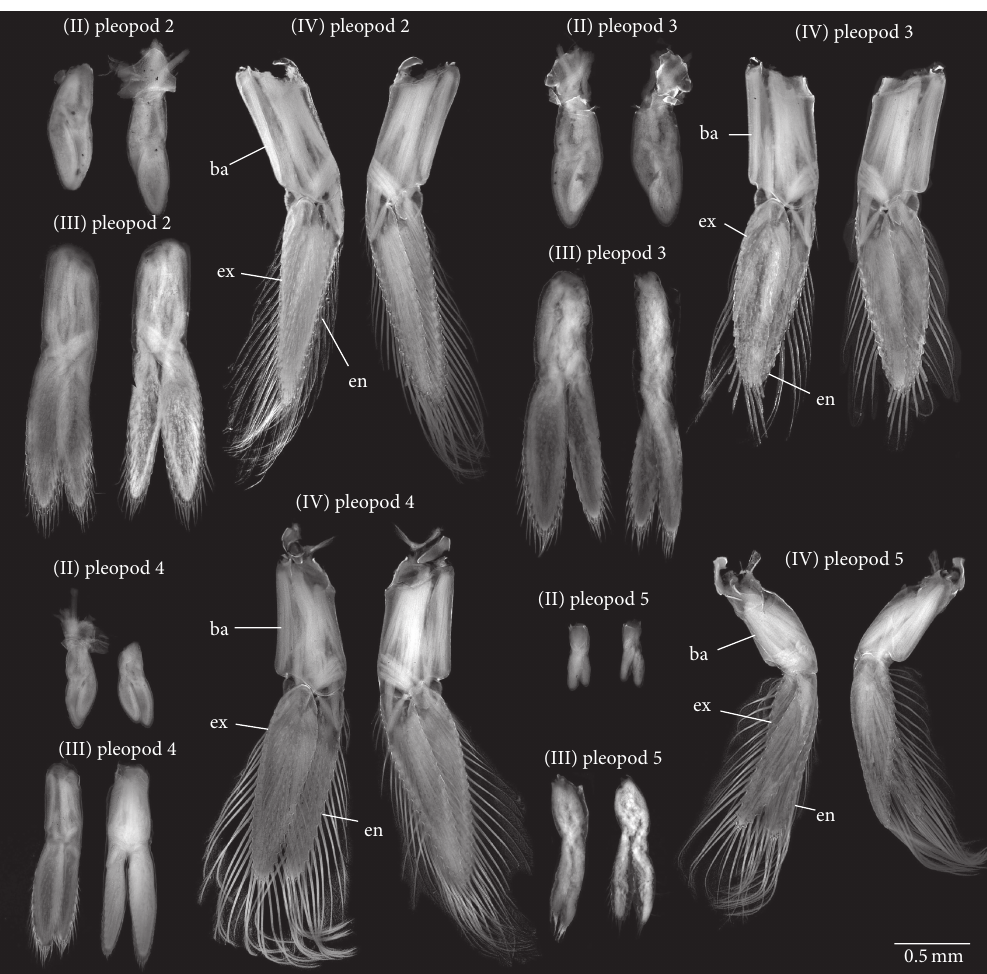
Figure 10: Pleopods 2–5 of larval stages (II) to (IV) of Homarus gammarus . Right appendage in anterior (left) and posterior (right) view, besides (IV) pleopod 5, which is left one flipped. Labeling only given in one instance due to the similarity of the structures throughout all stages. ba = basipod; en = endopod; ex =